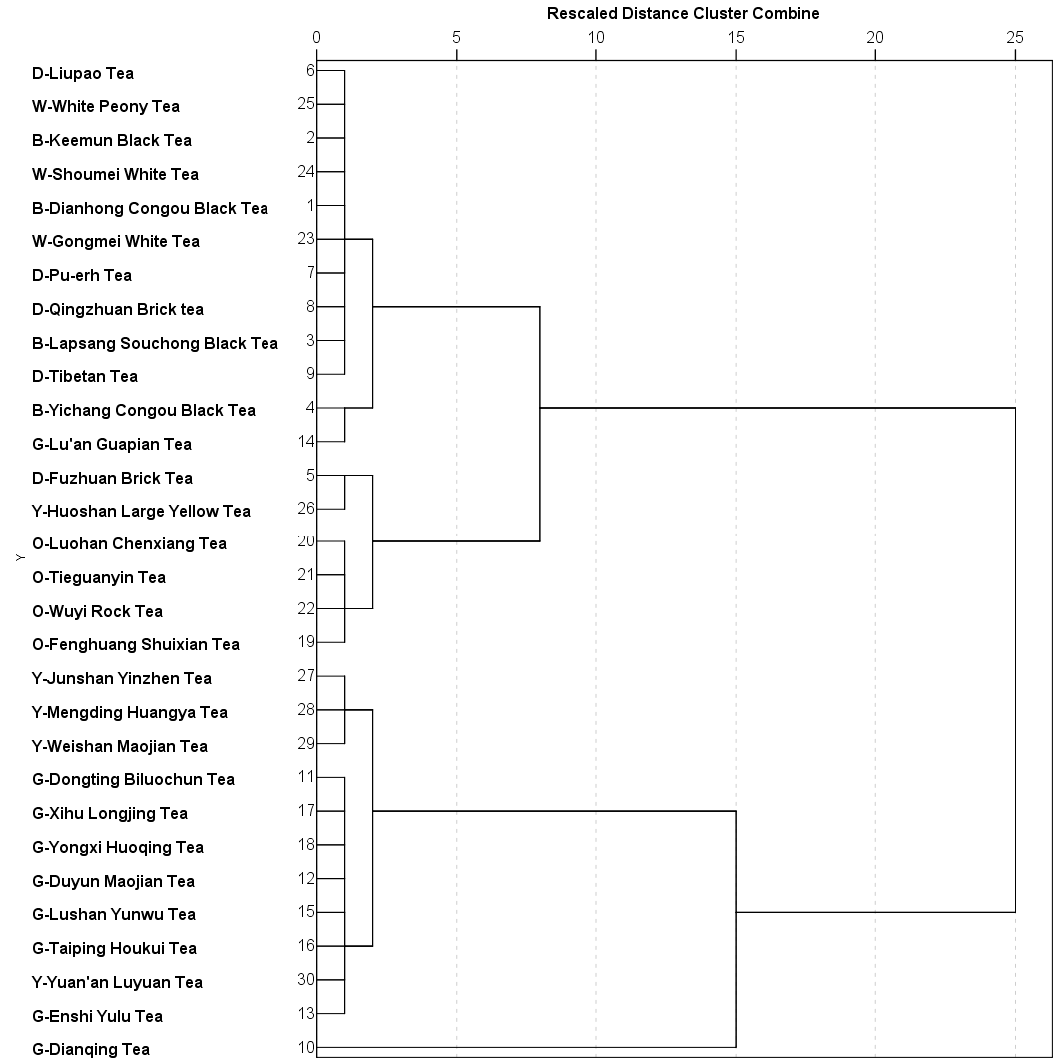
Figure 2. Dendrogram using average linkage (between groups) from systematic cluster analysis for 30 Chinese teas. B, black tea; D, dark tea; G, green tea; O, oolong tea; W, white tea; Y, yellow tea.